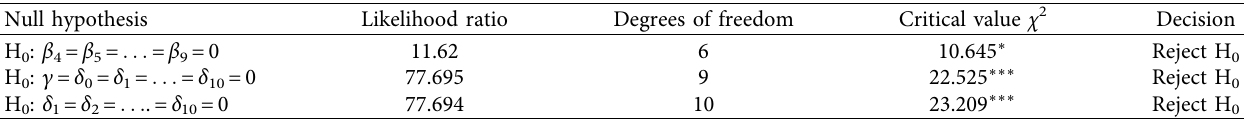
Table 2: Generalized likelihood ratio tests of the hypotheses for parameters of the stochastic production frontier and technical inefciency models for the small-scale trawl net in the Mekong Delta.